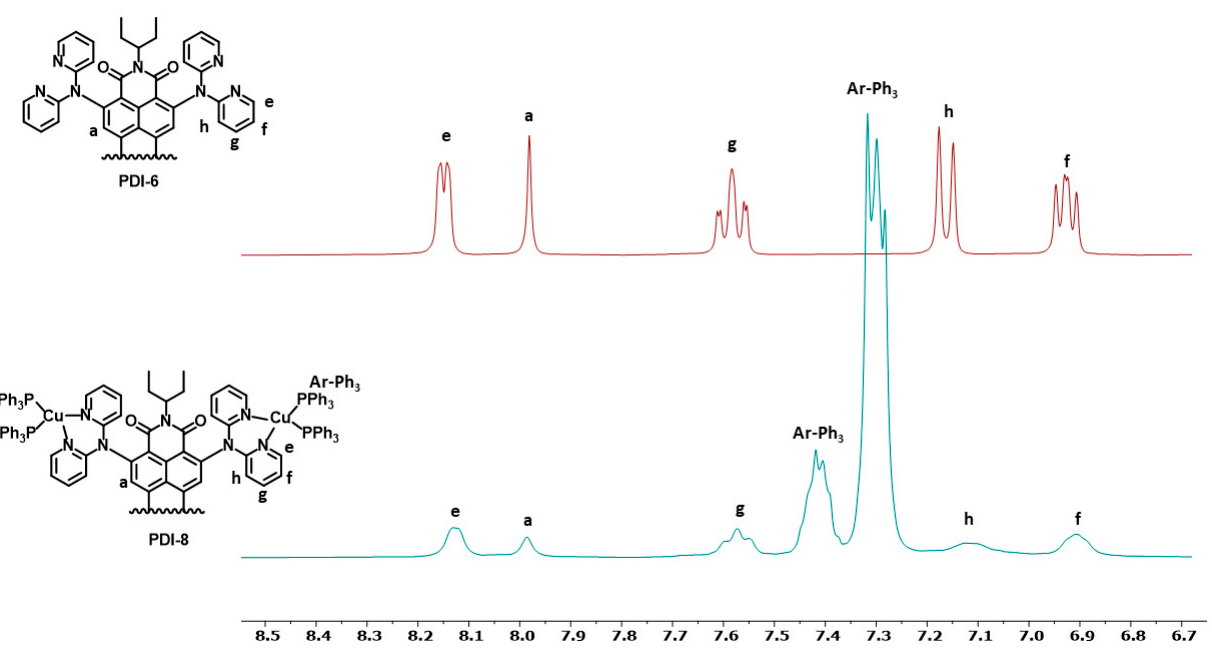
Figure 2. Part of 1 H NMR of PDI-6 (red) and PDI-8 (blue) in CD 2 Cl 2 at 25 °C.